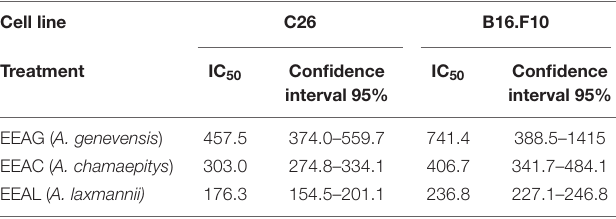
TABLE 4 | Cytotoxicity of Ajuga sp. ethanolic extracts against C26 and B16.F10 murine cancer cell lines by ELISA BrdU-colorimetric immunoassay (IC 50 value, µ g/mL).